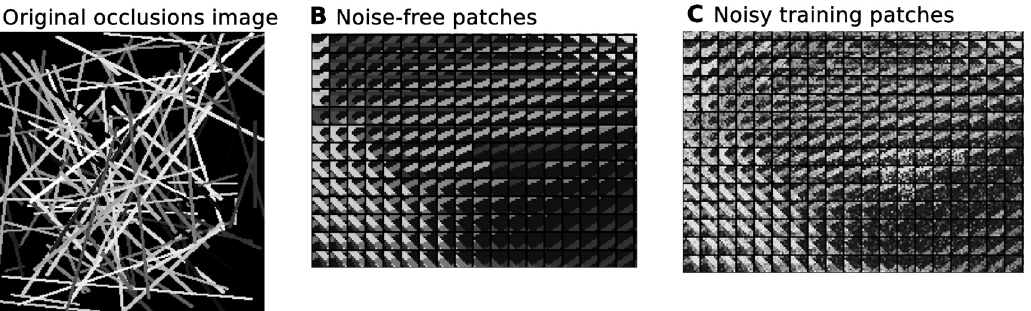
Fig 5. Synthetic occlusion dataset and cut – out original and noisy patches. Examples taken from the occlusion dataset. A shows an original noise-free image of generated occluding strokes of random width, pixel intensity, and starting/ending points. B shows a handfull of overlapping image patches cut from the original, noise-free data. C shows examples of the noisy training data, with independent σ = 25 noise added to B